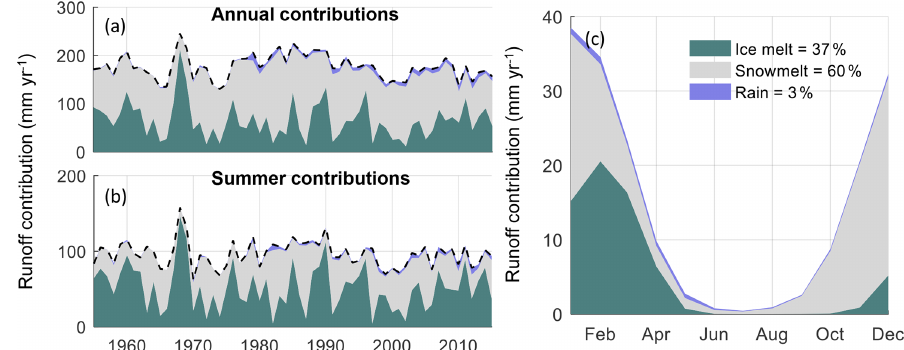
Figure 7. Runoff contribution from ice melt, snow melt, and rain from the headwater regions defined by the 1955 glacierized areas. The units are normalized by the Maipo River basin area. (a) Total annual contribution, (b) summer contribution, and (c) seasonal average contribution are given. The percentages of each contribution over the period 1955–2016 are indicated in the